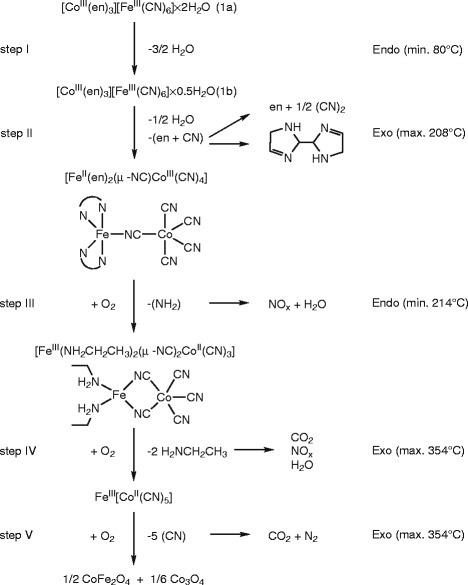
Suggested scheme of thermal decomposition of [CoIII(en)3][FeIII(CN)6]⋅ 2H2O (1a) during dynamic heating in air atmosphere. (Endo stands for endo-effects, while Exo for exo-effects).